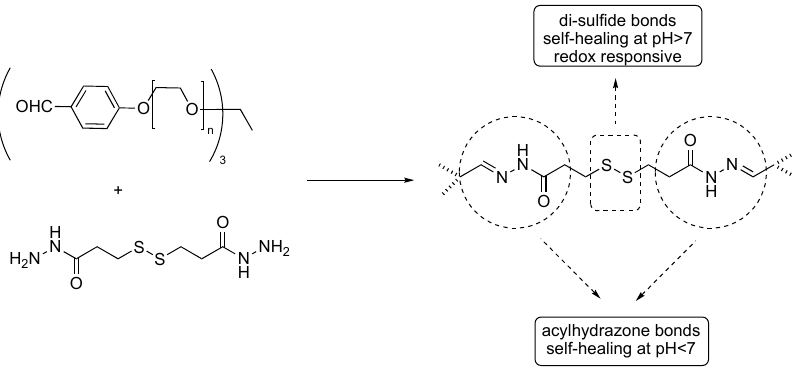
Figure 5. Dynamic hydrogels based on di-sulfide and acylhydrazone chemistry. Adapted and re-drawn from [39].